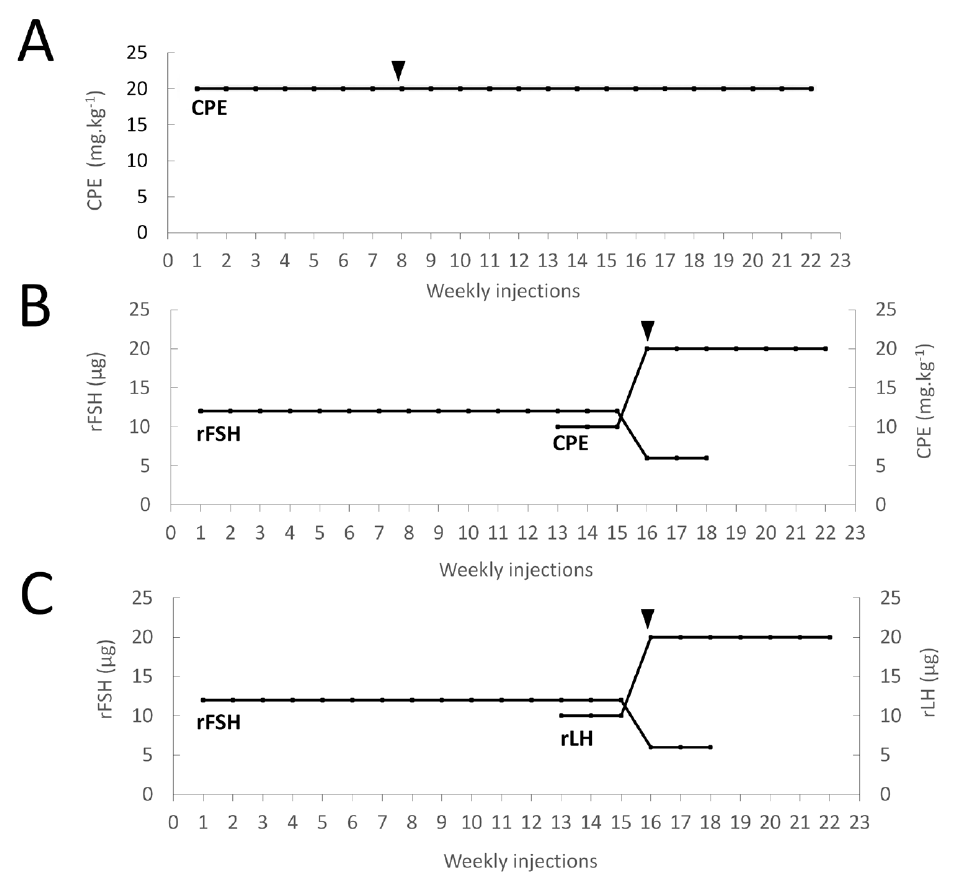
Figure 1. Schematic representations of the treatment administrated to each of the three groups of feminized eels, with ( A ) group 1: CPE (N = 10); ( B ) group 2: rFSH-CPE (N = 10); ( C ) group 3: rFSH-rLH (N = 10). For group 1, females were weekly injected with 20 mg kg − 1 CPE. For group 2, females were weekly injected with 12 µ g rFSH (week 1–12), 12 µ g rFSH and 10 mg kg − 1 CPE (week 13–15), 6 µ g rFSH and 20 mg kg − 1 CPE (week 16–18), and 20 mg kg − 1 CPE from week 18 onwards. For group 3, females were weekly injected with 12 µ g rFSH (week 1–12), 12 µ g rFSH and 10 µ g rLH (week 13–15), 6 µ g rFSH and 20 µ g rLH (week 16–18), and 20 µ g rLH from week 18 onwards. Females started to release eggs (black arrows) at week 8 for group 1 and week 16 for groups